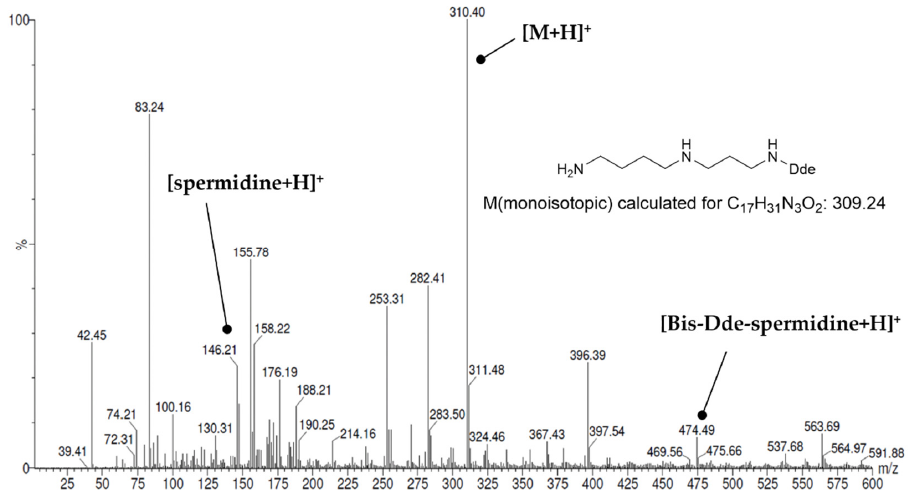
Figure 4. ESI(+) mass spectrum after protection of resin-bound spermidine as Dde-spermidine ( VI ). A disadvantage of the Dde protecting group is the transfer to other primary amino groups in the same molecule [38]. Therefore, mono-protection of molecules with multiple primary amino groups is not possible. However, the susceptibility of Dde to primary amino groups is exploited for its cleavage, for which treatment with 2% hydrazine in DMF has been established as a suitable method. The driving force in the cleavage represents the irreversible formation of 3,6,6-trimethyl-4-oxo-4,5,6,7-tetrahydro-1 H -indazole, the for- mation of which can be followed at 300 nm (or also 270 or 290 nm [74,76]). For the cleavage of the Dde protecting group from the polyamine derivatives, the resin was repeatedly treated with 2% hydrazine in DMF for 15 min each, and the extinction at 300 nm was determined for all filtrates. Compared to spermidine, the Dde cleavage of spermine re- quired fewer hydrazine treatments. This can be likely attributed to the longer chain length